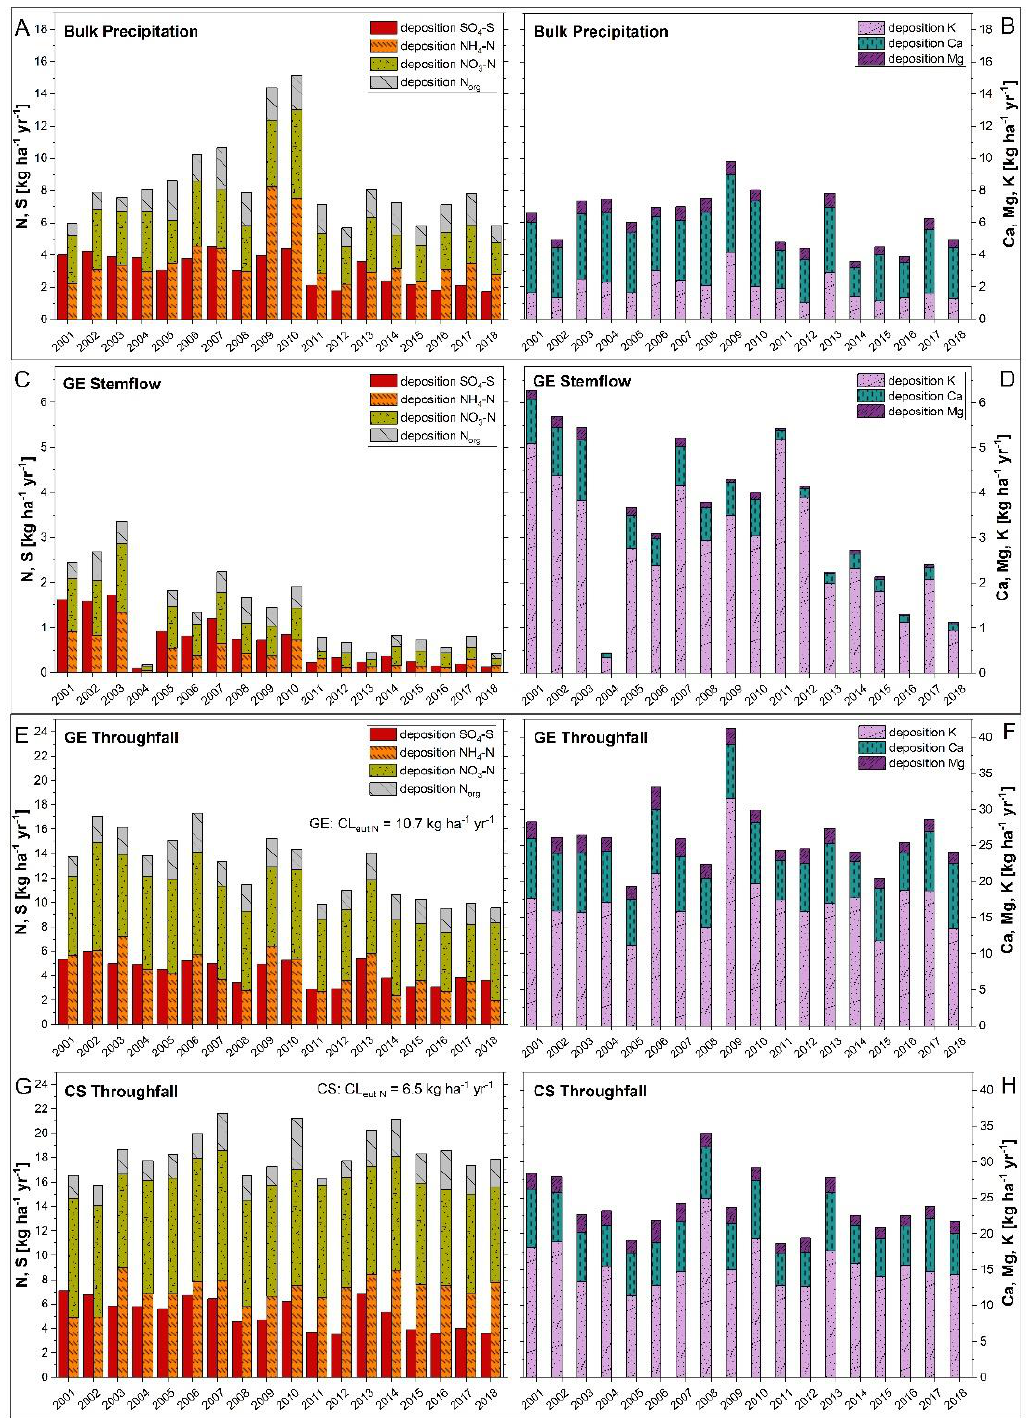
Figure 3. Deposition patterns of NH 4 -N, NO 3 -N, N org , SO 4 -S and base cations (K + , Ca 2+ , Mg 2+ ) of bulk precipitation ( A , B ), stemflow ( C , D ), and throughfall ( E – H ) within the forest hydrological cycle at the plot-pair GE/CS ICP between 2001 and 2018. The site was observed in the framework of the ICP Forests Intensive Monitoring Programme (Level-II; ThüringenForst). Forest-type-specific critical loads [17] for eutrophying nitrogen (CL eutN ; kg ha −1 yr −1 ) and acidifying sulfur (CL maxS ; kg ha −1 yr −1 ) were calculated after the simple mass balance model [52,53] . Total N-depositions in throughfall reach ecological relevant values (CL eutN is exceeded mostly before 2012 for GE and is exceeded in the whole investigation period for CS), whereas SO 4 -depositions are permanently clearly below the CL maxS (GE CL maxS : 17.5 kg ha −1 yr −1 ; CS CL maxS : 26.0 kg ha −1 yr −1 ). GE: Groups of European beech within stands of Norway spruce and Scots pine (CS) near Hummelshain (Thuringia, Central Germany).